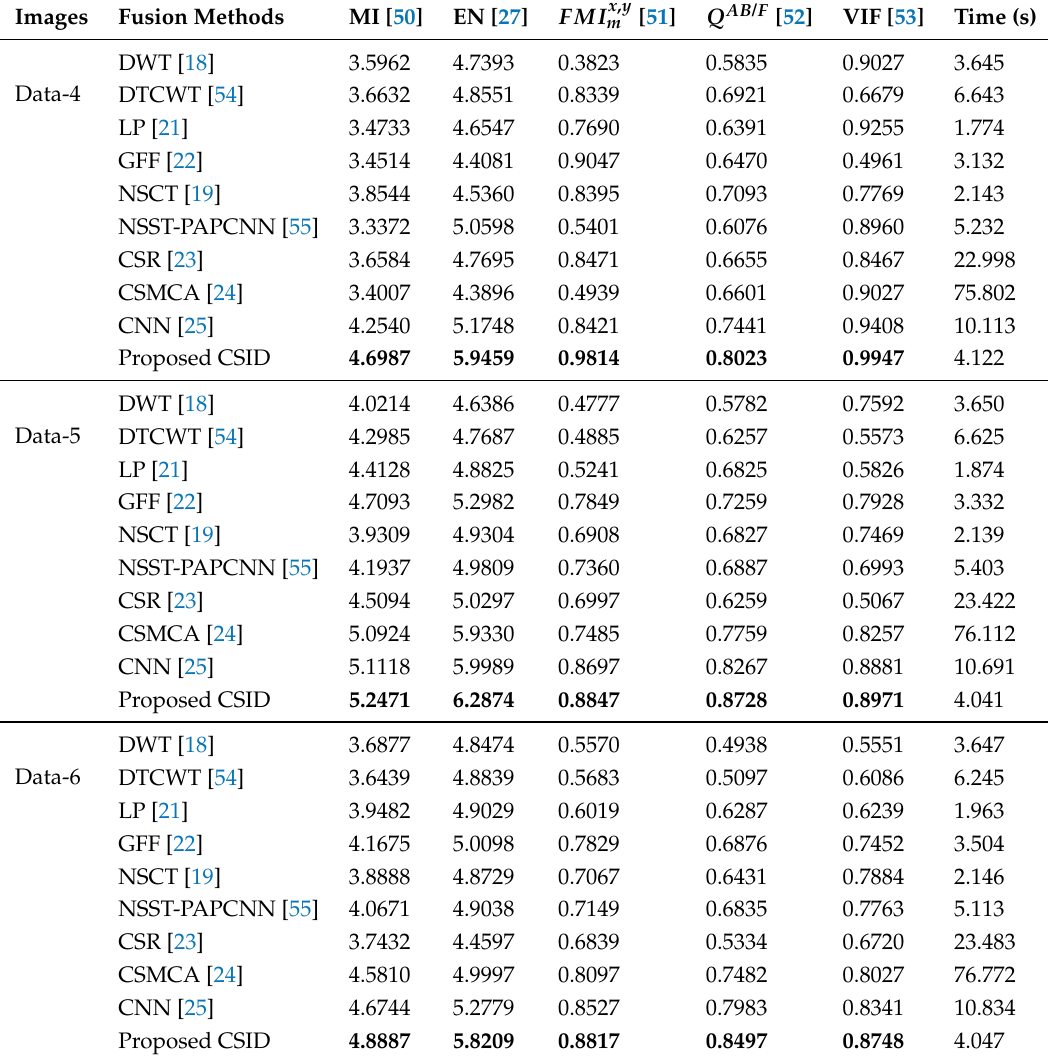
Table 2. The quantitative comparison of fusion methods. Best values are shown in bold.